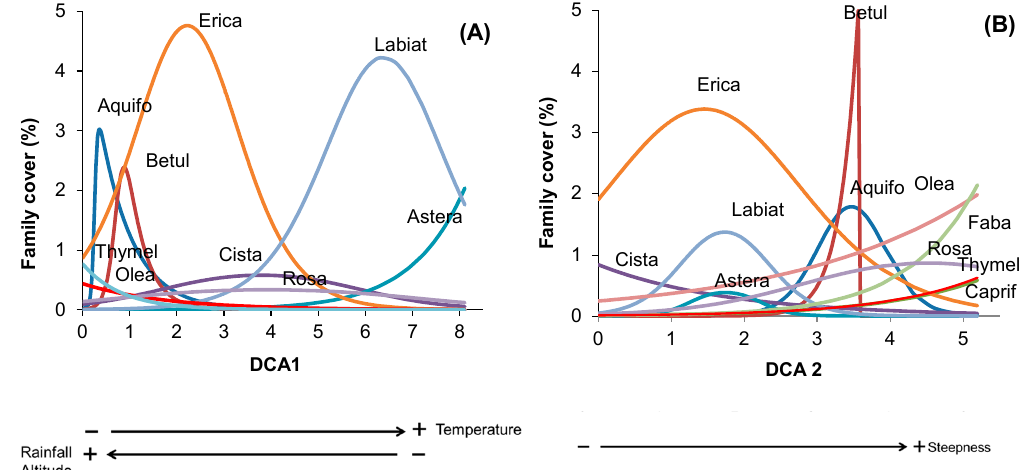
Figure 2. HOF-derived response curves for main taxonomic groups among shrubs in Palencia (Northern Spain), relative to the first ( A ) and second ( B ) main coenoclines (DCA1 and DCA2, respectively). Fabaceae (Faba) and Caprifoliaceae (Caprif) with HOF model I are not shown in Figure 2A. Codes are presented in Table 1, with the additional: Thymelaeaceae = Thymel; Oleaceae = Olea. Table 1. Location, along DCA1 and DCA2, of optimum ( μ ), top value (predicted maximum proba- bility), and niche widths based on 2 t tolerances for taxonomic groups with unimodal responses